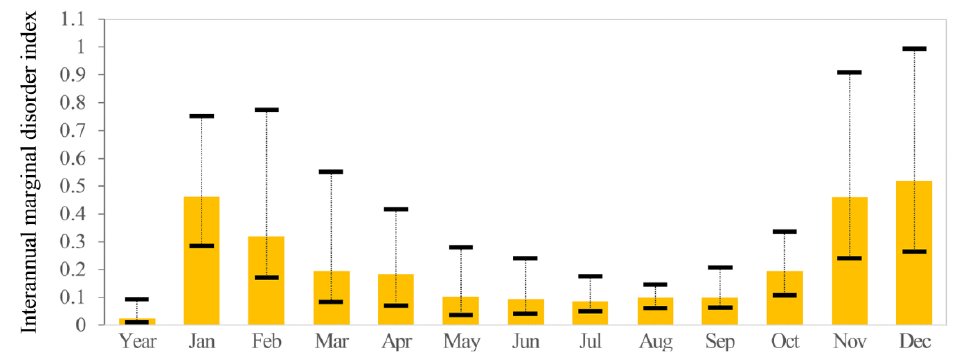
Figure 3. The mean and extreme of LMDI (long-term marginal disorder index) for annual and monthly precipitation series at 51 CMFD grids during 1979–2015.